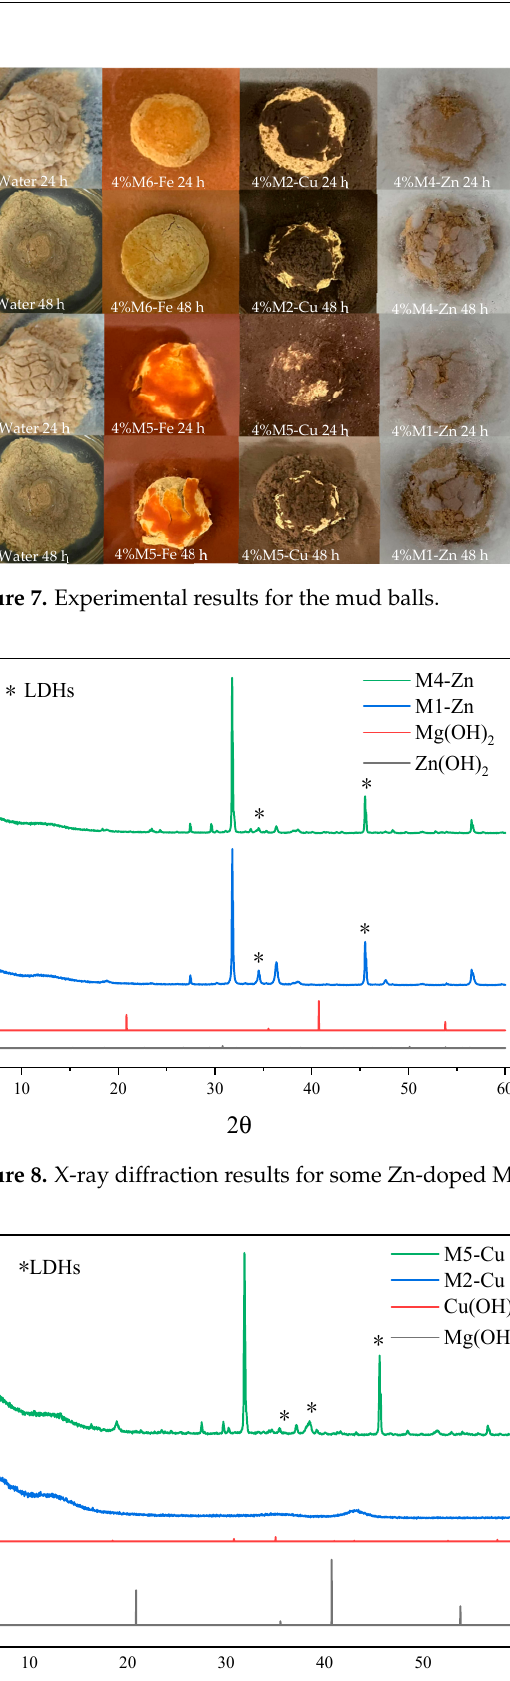
Figure 9. X-ray diffraction results for some Cu-doped MMH Figure 9 . X-ray diffraction results for some Cu-doped MMH samples.